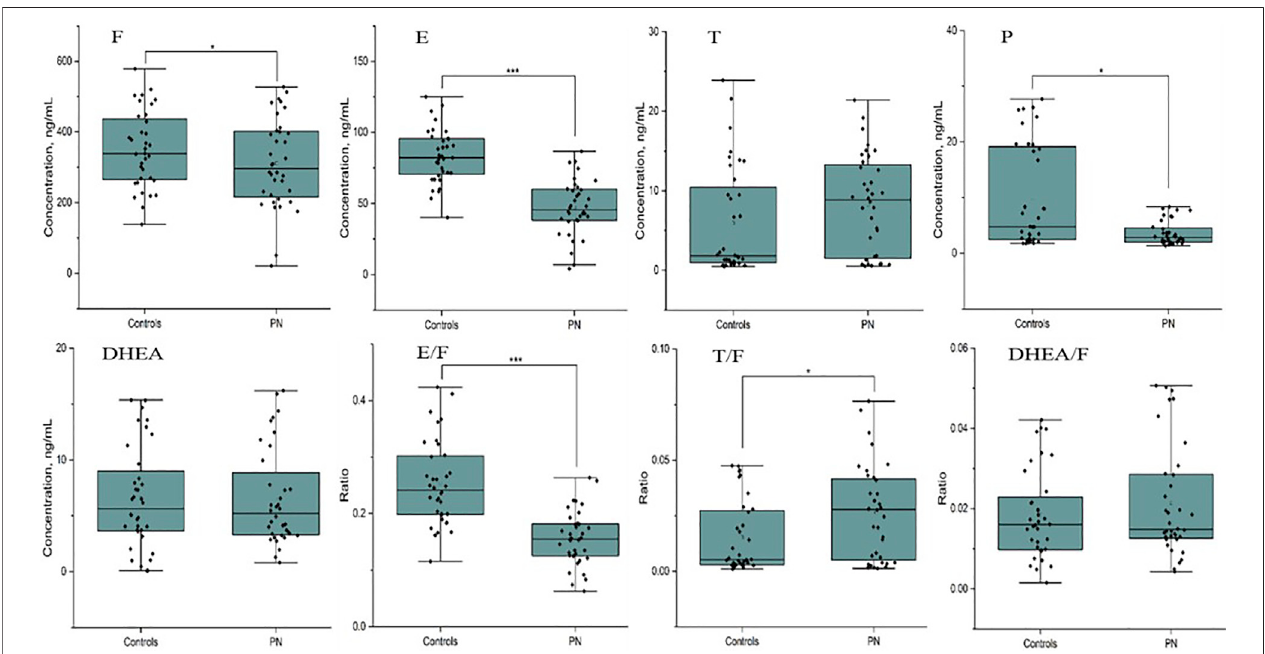
FIGURE 2 | Comparison of PN patients ( n = 36) and controls ( n = 36) in terms of steroids and their ratios in plasma.